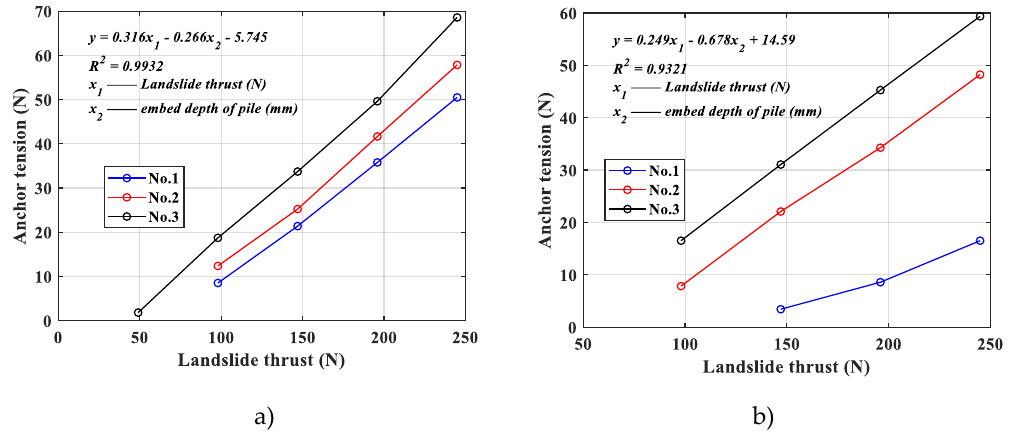
Figure 6. Comparison of anchor tension. ( a ) Anchor tension in epoxy resin pile model, ( b ) anchor tension in aluminum alloy pile model.